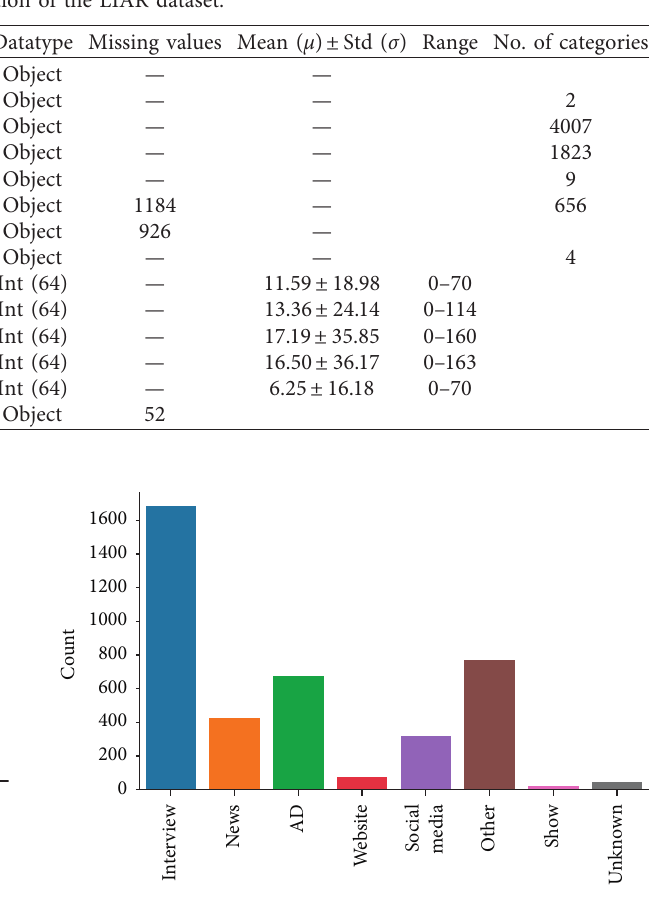
Figure 3: Number of records per category for venue attribute after